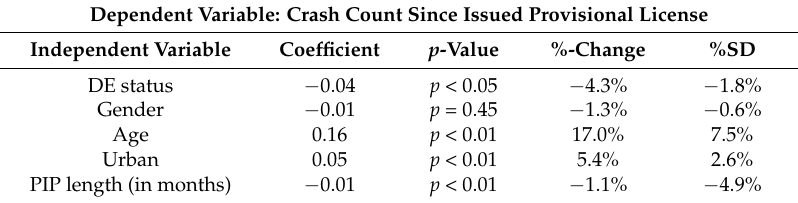
Table 3. Results from Poisson analysis of collision since issued provisional